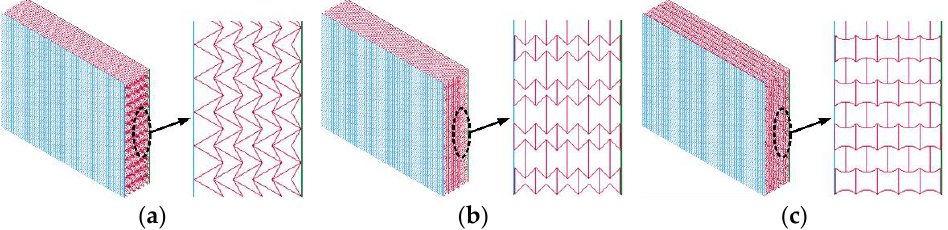
Figure 4. The FE model of sandwich panel. ( a ) configuration Ⅰ , Arrow-shape; ( b ) configuration Ⅱ , Concave hexagon-shaped; and ( c ) configuration Ⅲ , Concave arc-shaped